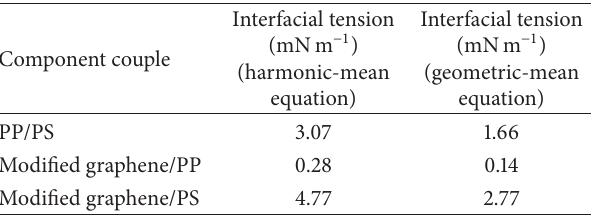
Table 3: Interfacial tensions of component couples.